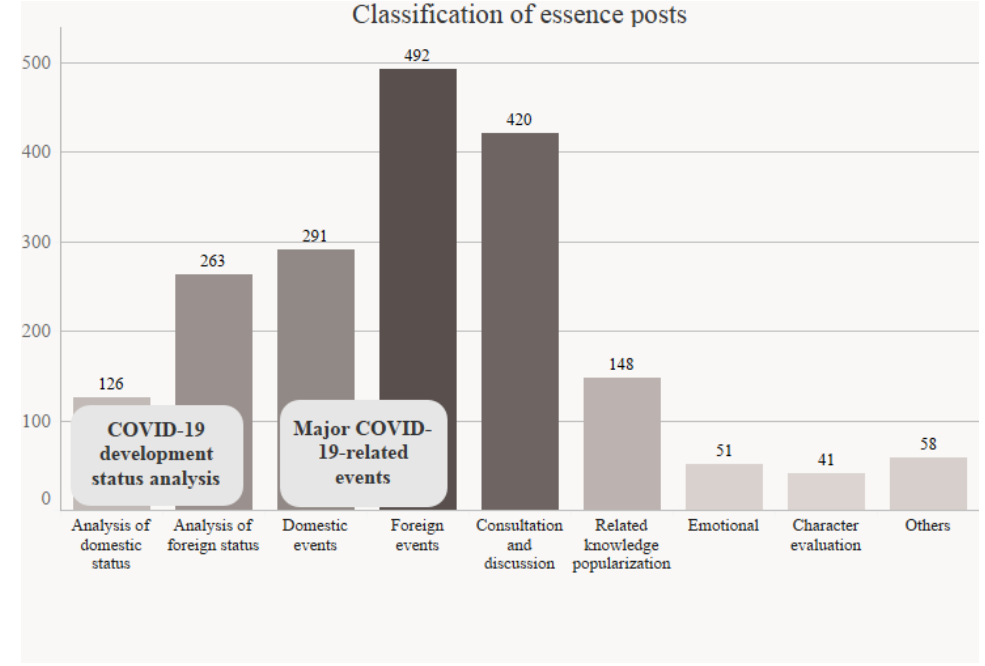
Figure 3. Classification statistics of essential posts in the COVID-19 theme community. Table 1. Information about opinion leaders (the top